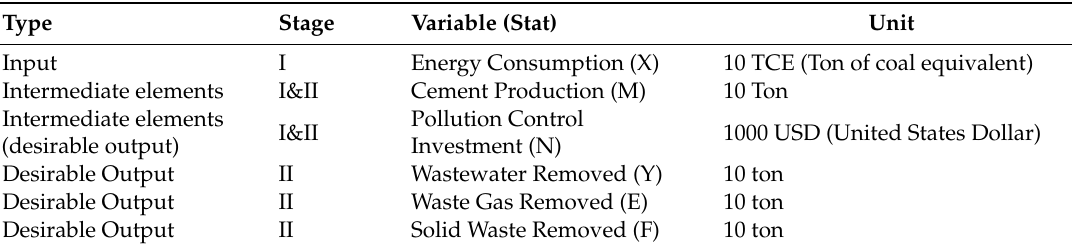
Table 1. The inputs, intermediate elements, and outputs for the 1ST DMUs.